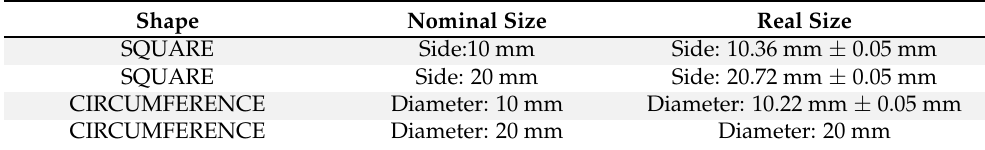
Table 2. Shapes selected and related